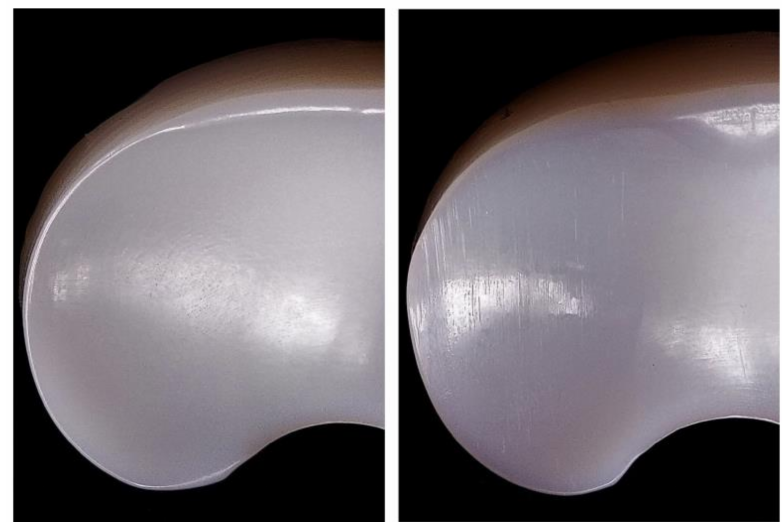
Figure 3. UHMWPE meniscus before ( left ) and after ( right ) the test.